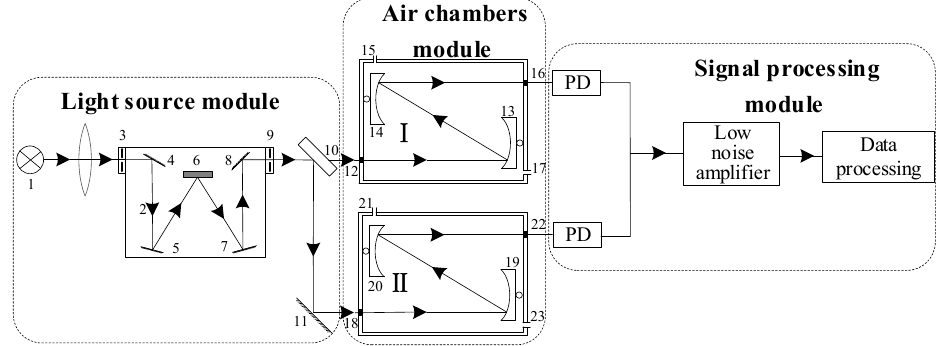
Figure 2. Structural diagram of methane gas detection system. 1—super light emitting diode light source; 2—condensing mirror; 3, 9—slit; 4, 8, 11—plane mirror; 5—collimator; 6—grating; 7—focus lens; 10—beam splitter; 12, 16, 18, 22—gradient index lens; 13, 14, 19, 20—spherical mirror; 15, 21—air inlet; 17, 23—air outlet.